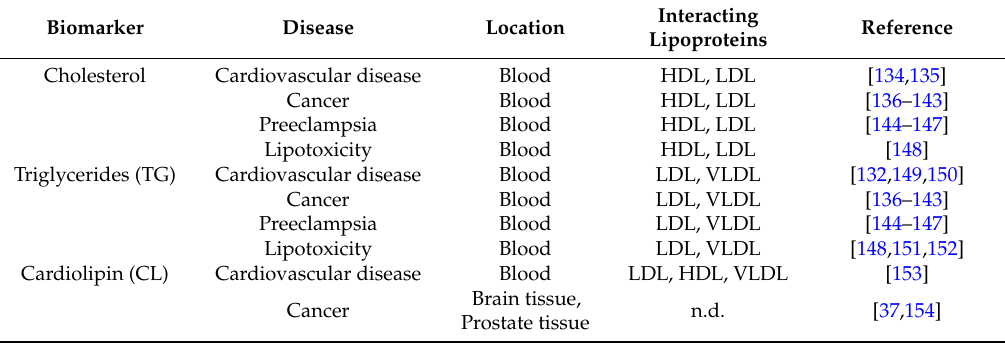
Table 3. Select lipid and amphiphilic biomarkers used for diagnosing non-infectious diseases. Biomarker Disease Location